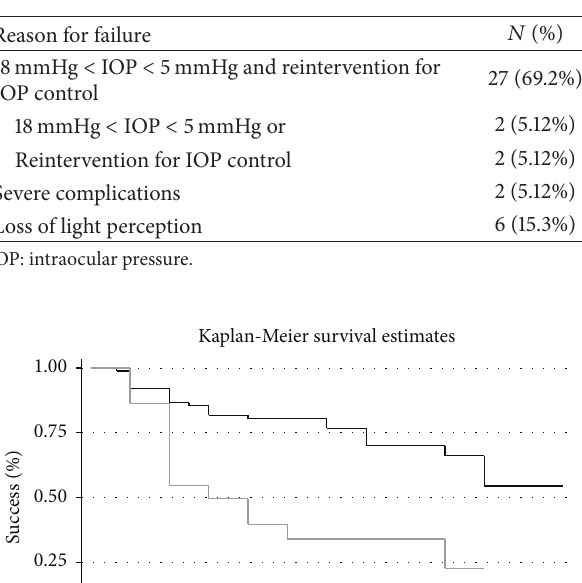
Table 3: Reasons for treatment failure after Ahmed Glaucoma Valve surgery.